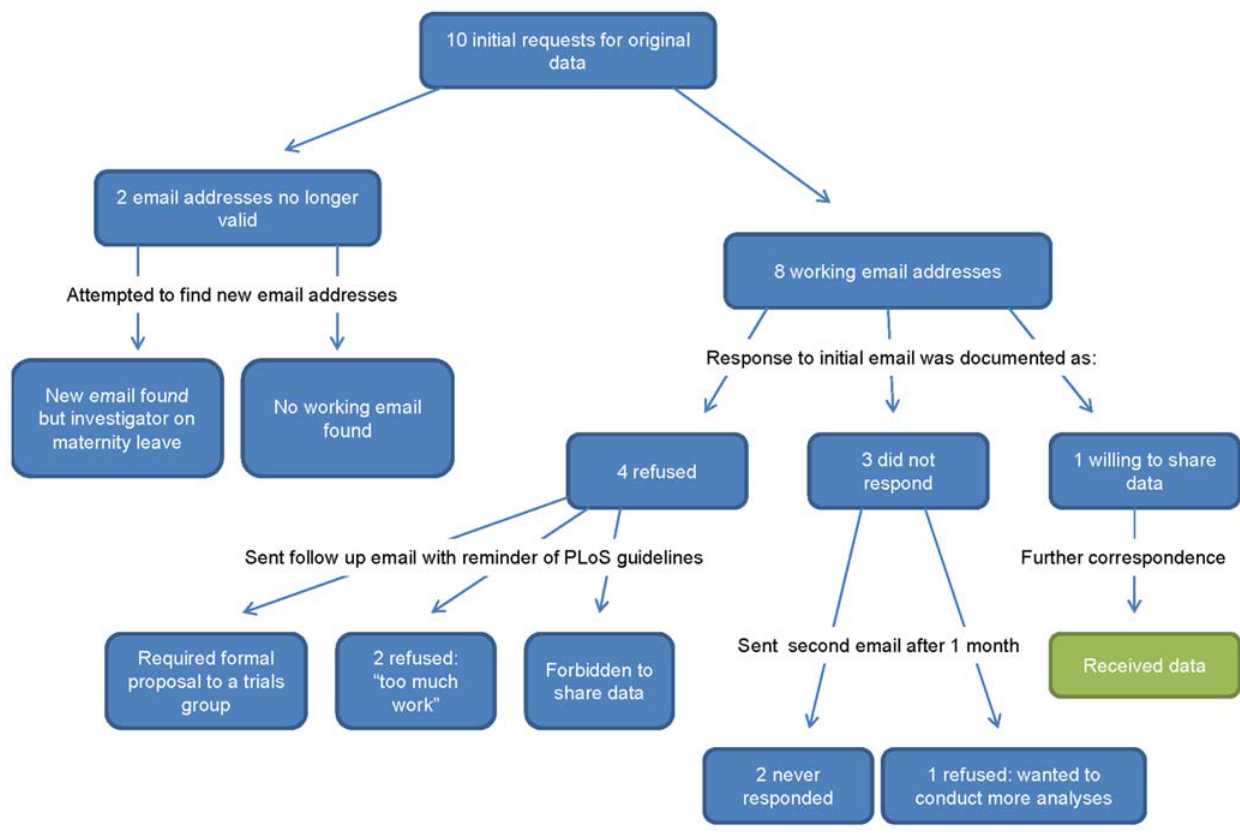
Figure 1. Summary of responses to the 10 initial requests for raw data.